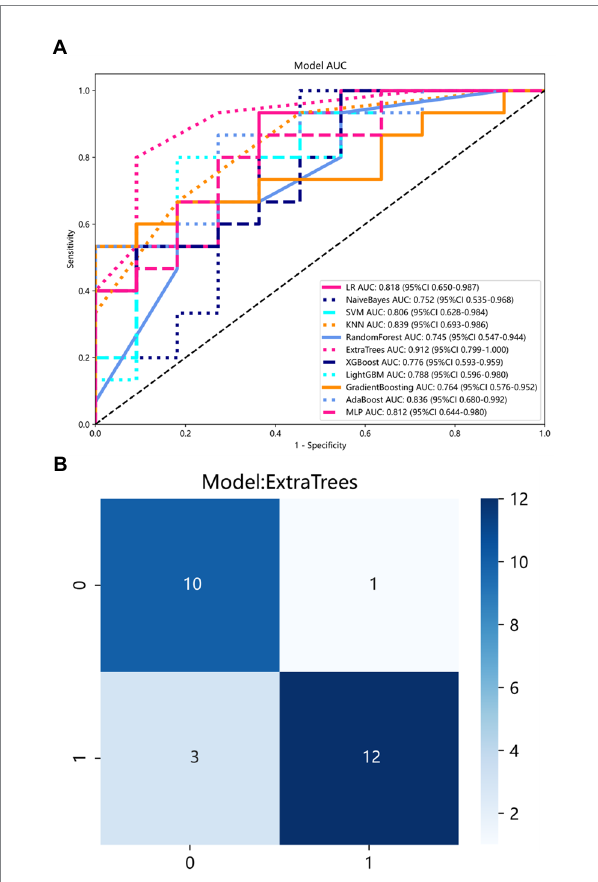
FIGURE 5 (A) ROC curve of 11 models in the test set. Each color represents a model. (B) Confusion matrix for ExtraTrees model in the test set.